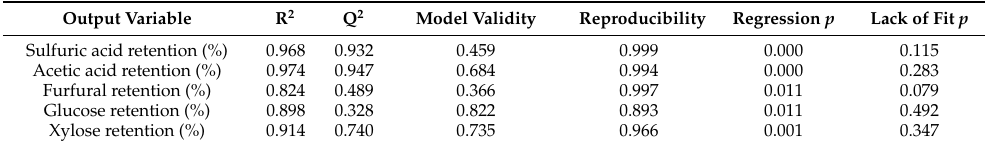
Table 5. Summary of results for the identified models.